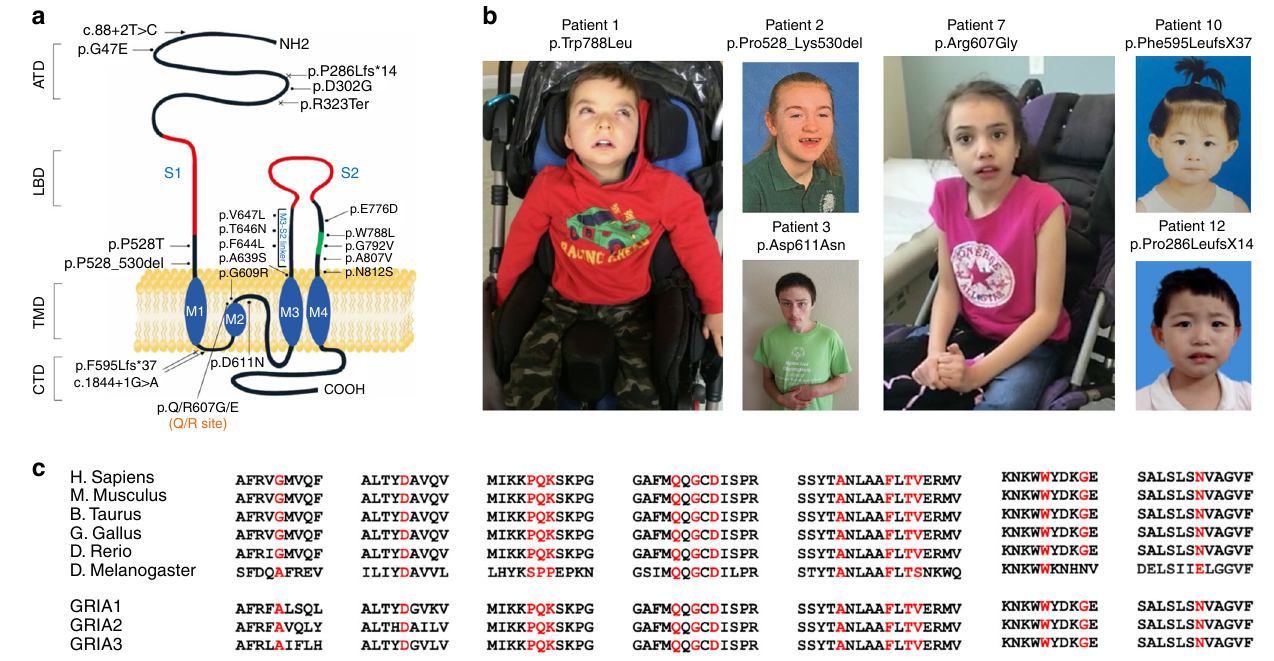
Fig. 1 GRIA2 intragenic de-novo variants identi fi ed in this study. a Schematic of the human GluA2 protein (NP_000817.2) indicating the positions of twelve missense changes (dot arrows), two frameshift deletions (cross arrows), two splice-site variants (arrows) and an in-frame deletion (dot arrow). Glutamate binding regions are displayed in red, fl ip/ fl op alternatively spliced region is represented in green. b Left panel: Patient 1, carrying the de-novo p.W788L GluA2 Flop variant, at 3 years, exhibitinghypotonia and an oculogyric crisis; he is wheelchair dependent. Middle left panel: Patient 2 (top) carrying the de- novo p.P528_K530del in-frame deletion, at 12 years; Patient 3 (bottom) carrying the de-novo p.D611N variant, at 18 years, exhibiting hand-wringing suggestive of RTT. Middle right panel: Patient 7, carrying the de-novo p.Q607E/p.R607G heterozygous mutation (affecting the Q/R editing site) at 10 years, exhibiting hand-wringing as part of a RTT-like presentation. Right panel: Patient 10 (top) carrying the de-novo p.F595LfsX37 variant, at 5 years; Patient 12 (bottom) carrying the de-novo p.P286LfsX14 at 6 years. c Multiple alignment showing GluA2 protein complete conservation across species and inter AMPAR homolog subunits (GluA1, GluA3, and GluA4) alignment. Human GRIA2 (NP_000817.2), mouse GRIA2 (NP_001077275.1), bos taurus GRIA2 (NP_001069789.2), gallus gallus GRIA2 (NP_001001775.2), danio rerio (NP_571970.2), drosophila melanogaster (NP_476855.1), Human GRIA1 (NP_000818.2) Human GRIA3 (NP_015564.4), and Human GRIA4